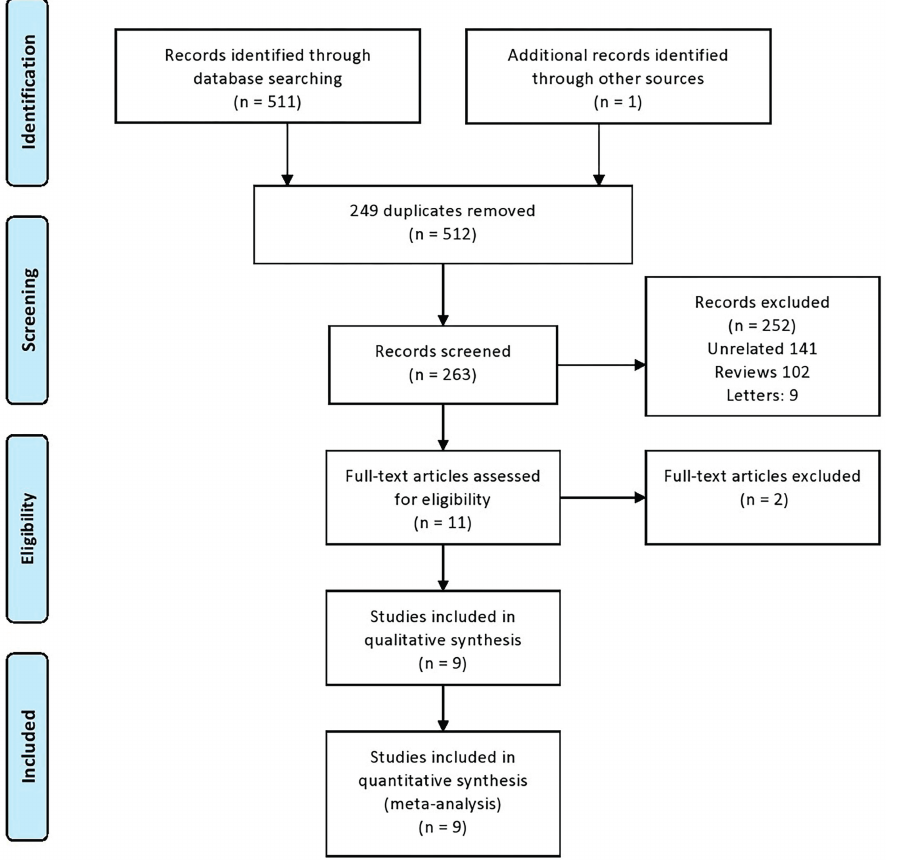
Figure-1 - PRISMA flow-chart depicting search strategy used during this